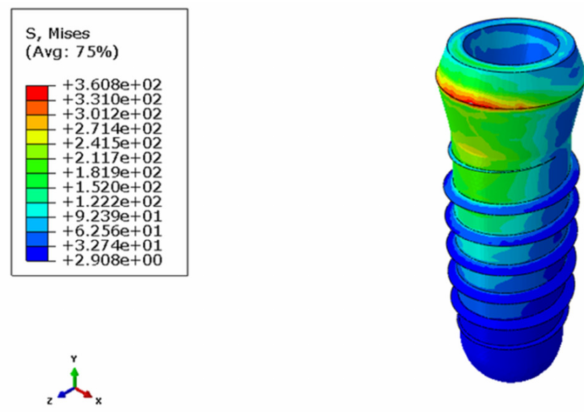
Figure 9. Stress distribution in the